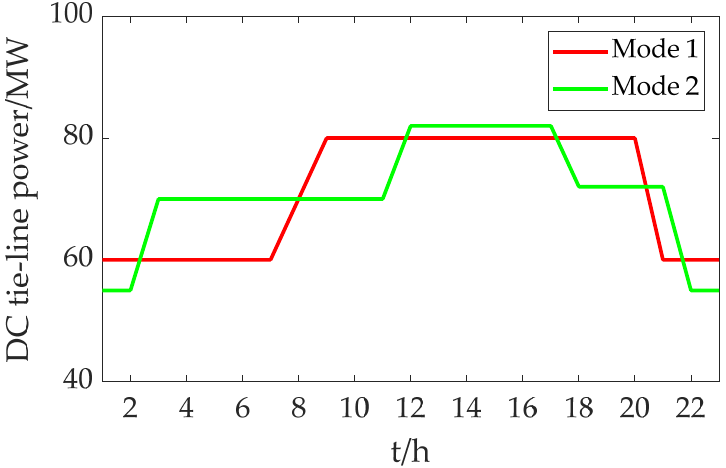
Figure 11. DC tie-line transmission plan in two transmission modes.